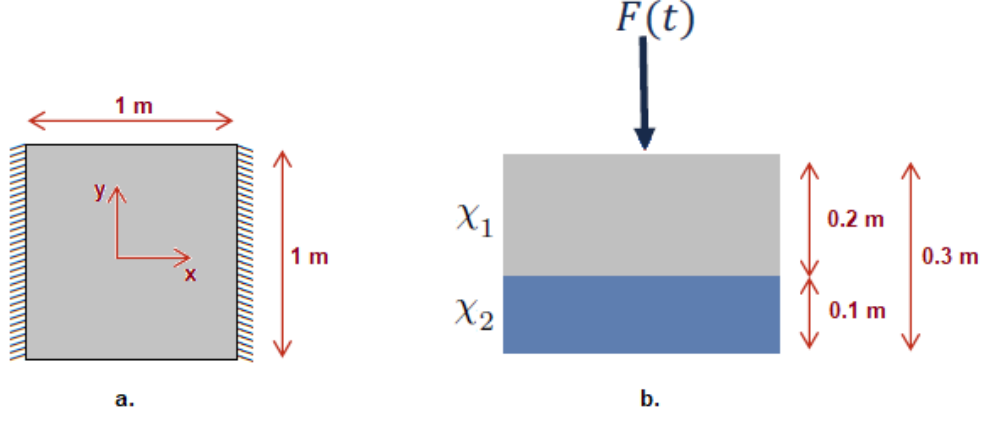
Figure 1. Case study: ( a ) In-plane view; ( b ) cross-sectional view.